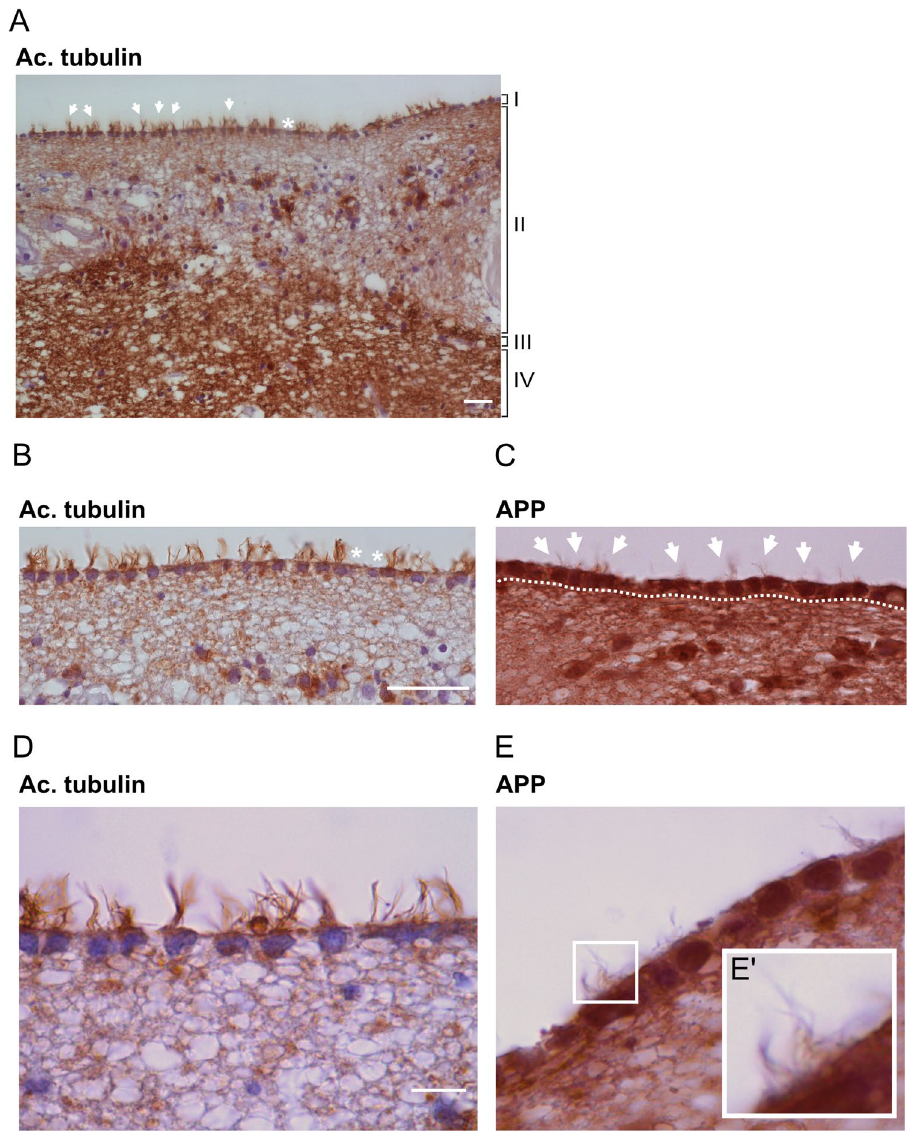
Figure 5. APP is localized to human ependymal cilia. ( A ) Brightfield overview of a human brain section of the caudate nucleus immunostained with an anti-acetylated tubulin antibody reveals the different cellular layers (I–IV): (I) ependymal layer with motile cilia orienting towards the ventricle lumen, (II) cellular extensions connecting the ependymal cells, (III) cellular layer dense in astrocytes, (IV) brain parenchyma. ( B – E ) Higher magnifications of the ependymal layer show clear cilia (acetylated tubulin ( B , D )) and APP (Y188 antibody ( C , E )) accumulation within ependymal cells and along ependymal cilia. ( E’ ). Arrows highlight ependymal cilia tufts in the ventricular lumen. White asterisks indicate broken or absent cilia. Dotted lines delimitate the ependymal cell layer. Magnification: ( A ) = 20×, ( B , C ) = 40×, ( D , E ) = 100×. Scale bar: ( A ) = 5 µm, ( B ) = 10 µm, ( D ) = 2